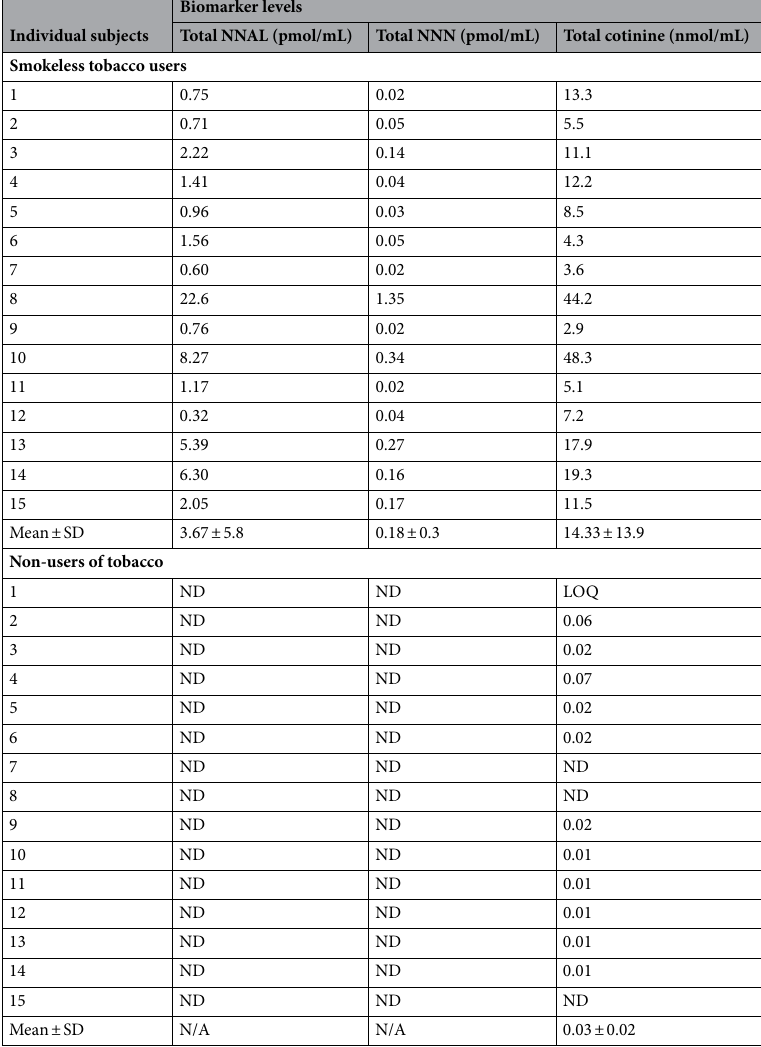
NNN, N ′ -nitrosonornicotine, ND, not detected; LOQ, limit of quantitation; N/A, not